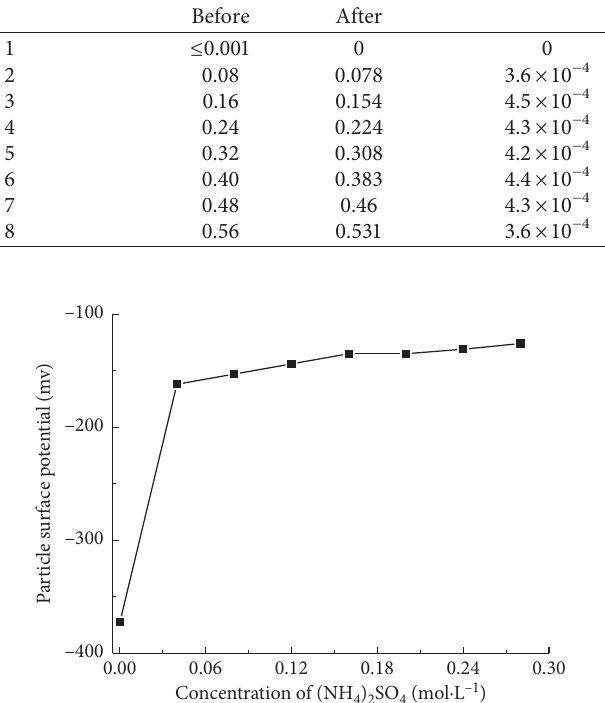
Table 1: Main indexes of ore samples with initial particle size of less than 0.075mm. Sample no.